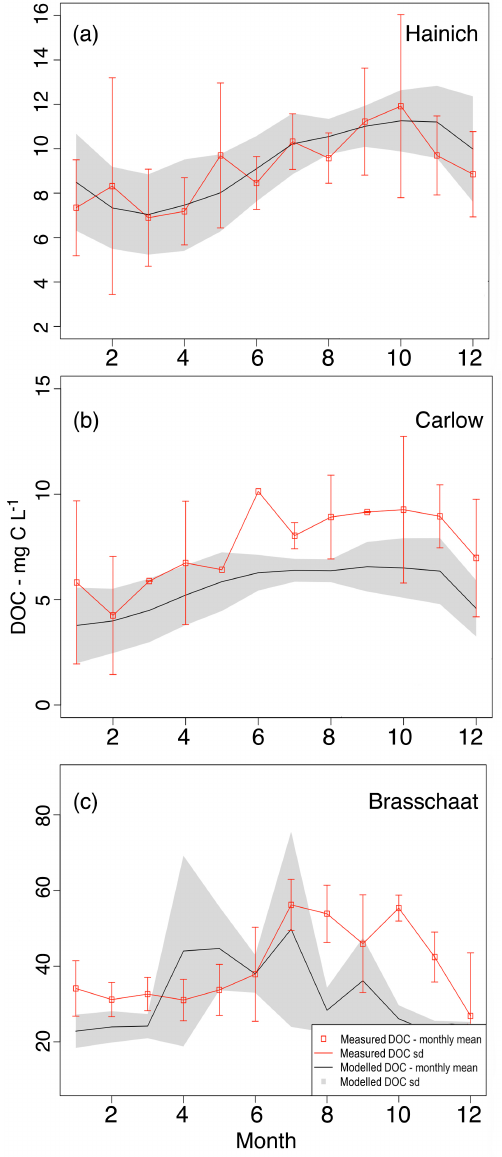
Figure 5. (a) Monthly DOC (mgCL − 1 ) at 10cm in Level 1 sites modelled (black line: mean, grey line: standard deviation) versus measured (red square: mean, red line: standard deviation) for the studied period: (a) Hainich average from 2005 to 2014, (b) Carlow average from 2006 to 2008, (c) Brasschaat average from 2006 to 2010. Results for other depths are given in Fig.